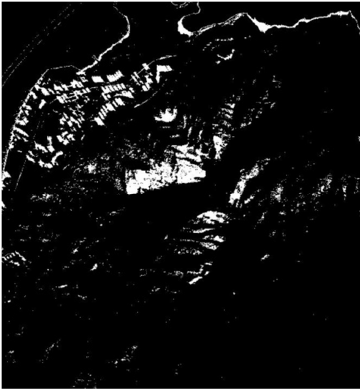
Figure 6. Ma On Shan - shadow extraction result For Ma On Shan, shadows by mountainous areas and buildings are extracted. However, the natural coast areas are being misclassified as shadows. These areas are in fact, shallow water (shown in Figure